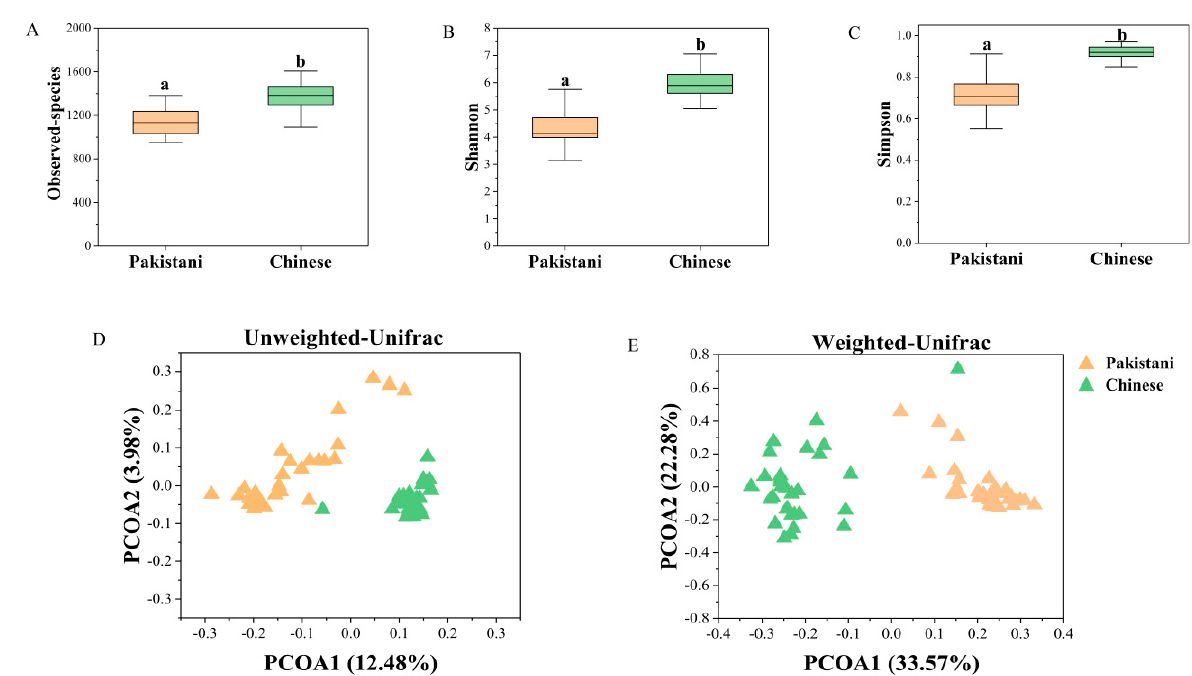
Figure 4. The comparison of alpha diversity based on observed-species ( A ), Shannon diversity ( B ), Simpson ( C ), and microbial community ( D , E ) between Chinese and Pakistani. The alpha diversity was compared by the Mann–Whitney U test. The mark of (a) and (b) indicated a significant difference between two groups ( p < 0.05). Community structure with obvious separations were compared by PCOA based on unweighted uniFrac distance ( D ) and weighted uniFrac distance ( E ).